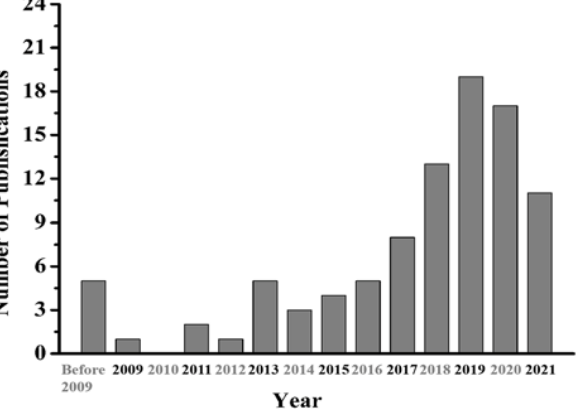
Figure 2. Number of publications involving the PAMAM-grafted adsorbents for heavy metal ions from 2006 to 2022. (Searched from web of science).